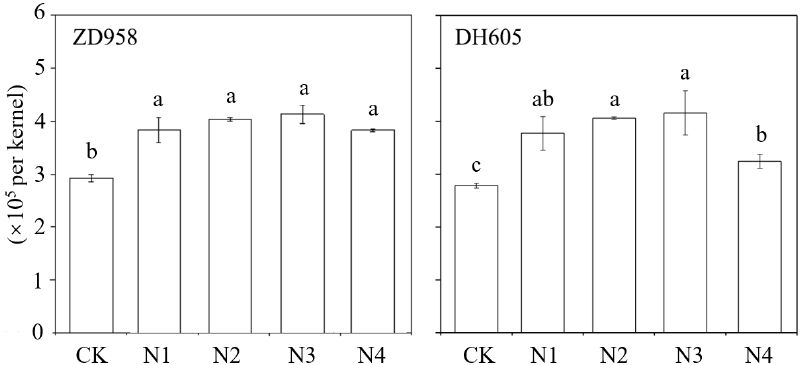
Figure 4. Effects of N treatments on endosperm cell number at 15 days after silking in 2016. One-way analysis of variance with Duncan’s new multiple range test was conducted to assess the statistical patterns. Different letters indicate a significant difference ( p < 0.05).